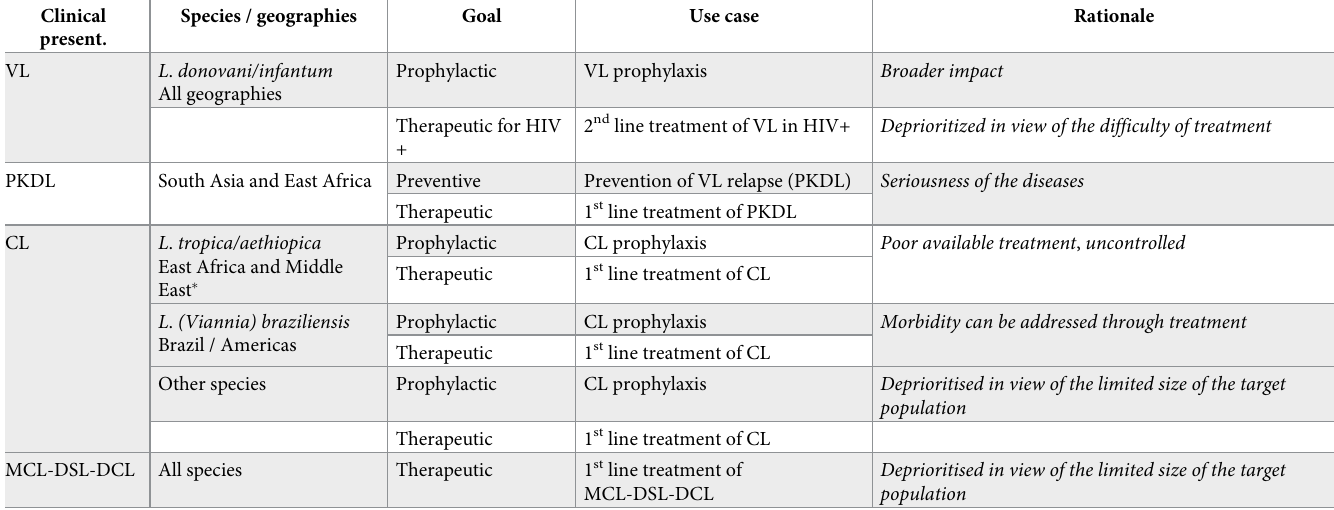
Table 3. Leishmaniasis vaccine use cases definition and prioritisation. Clinical present.